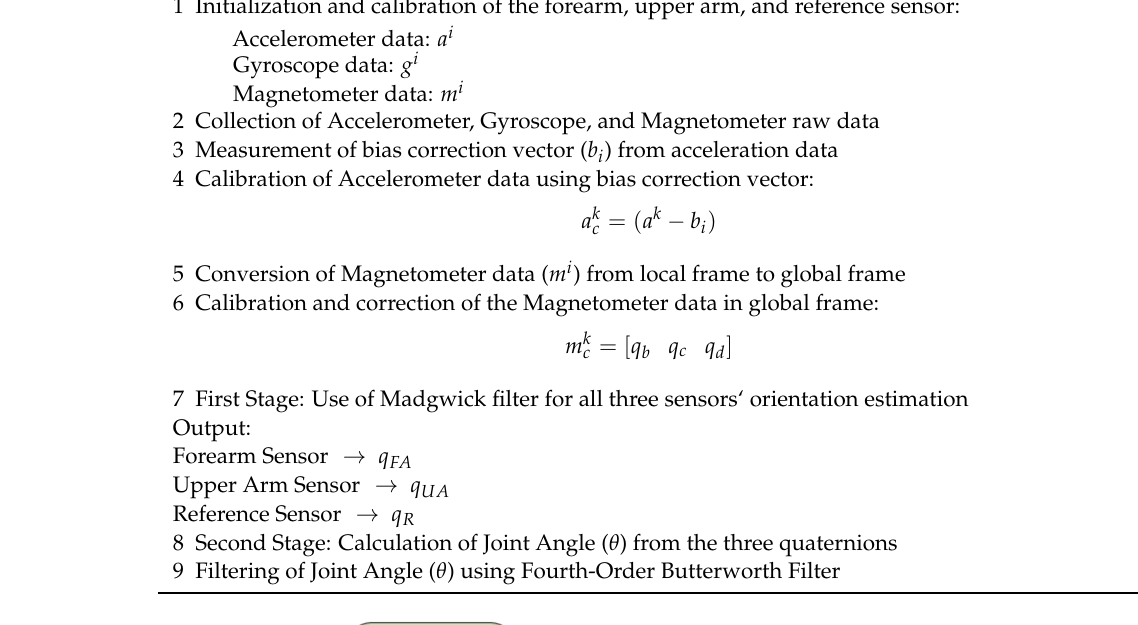
Algorithm 1 Proposed Joint Angle Measurement Algorithm